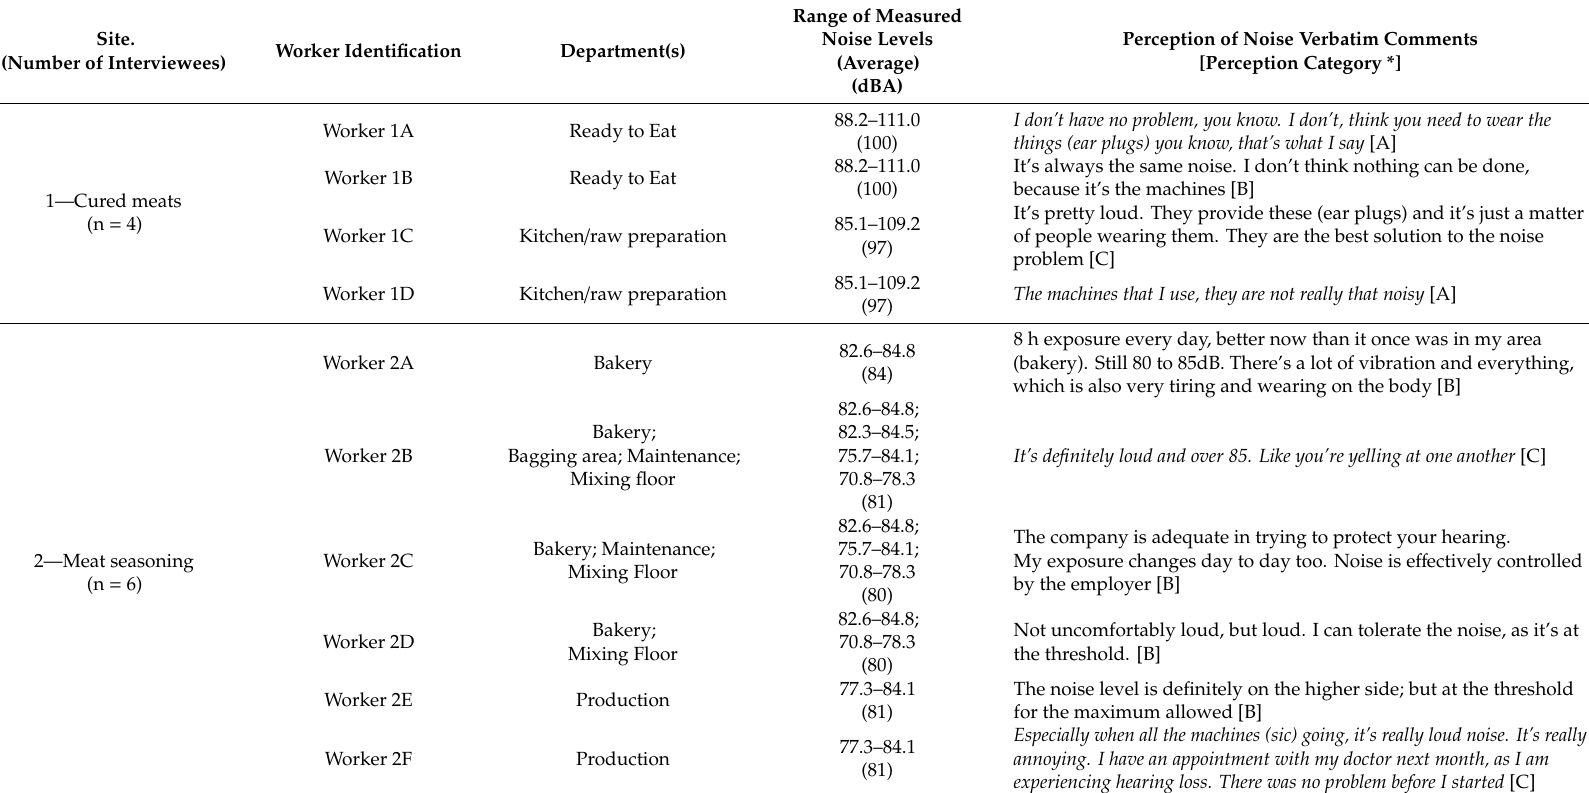
Table 3. Workers’ perception of noise vs. measured noise levels. Divergent results are italicized. Divergence = noise measurement was ≥ 85 dBA and the corresponding worker perception was that it was not noisy (or vice